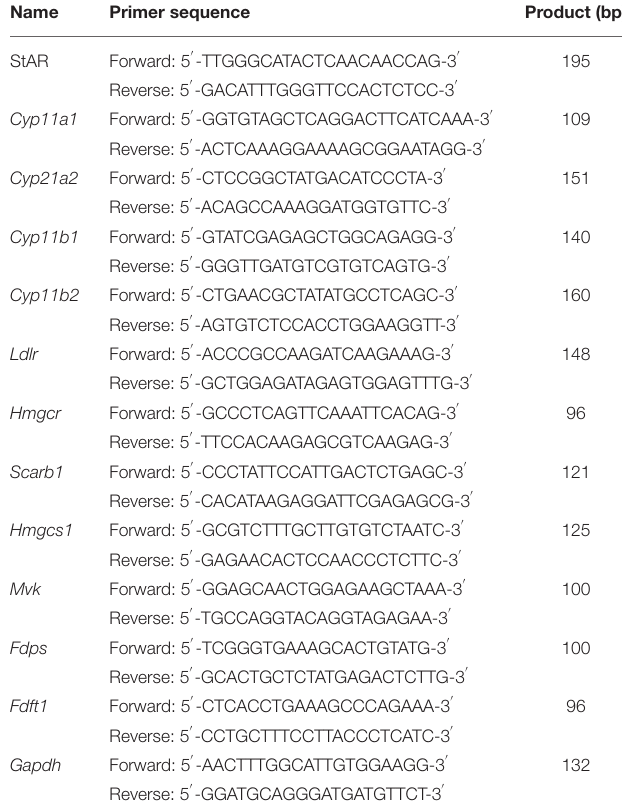
TABLE 1 | Sequences of the